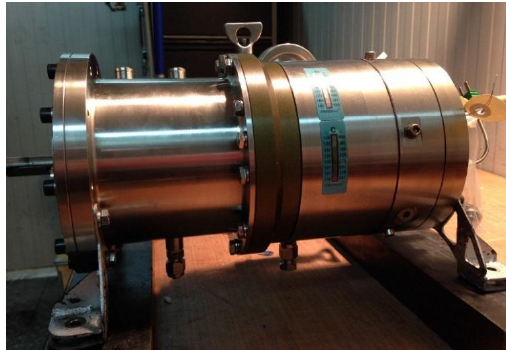
Figure 3. Swash-plate expander delivered by Exoès.